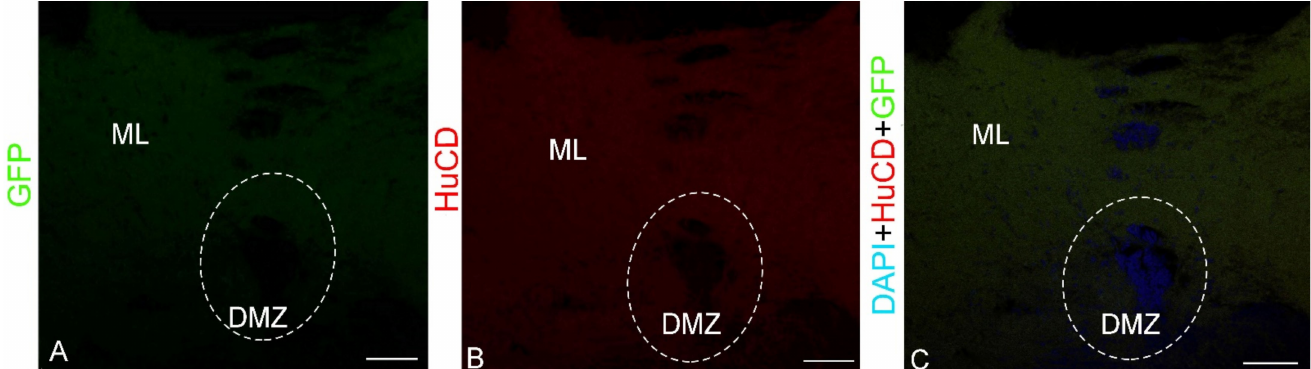
Figure 2. Results of the control immunolabeling experiments for HuCD and GFP in the dorsal part of the cerebellar body in the absence of primary antibodies. ( A ) GFP; ( B ) HuCD; ( C ) DNPI + HuCD + GFP. Dorsal matrix zone (DMZ) is in the white dotted rectangle. ML, molecular layer. Laser scanning confocal microscopy. Scale bar: 100 µ